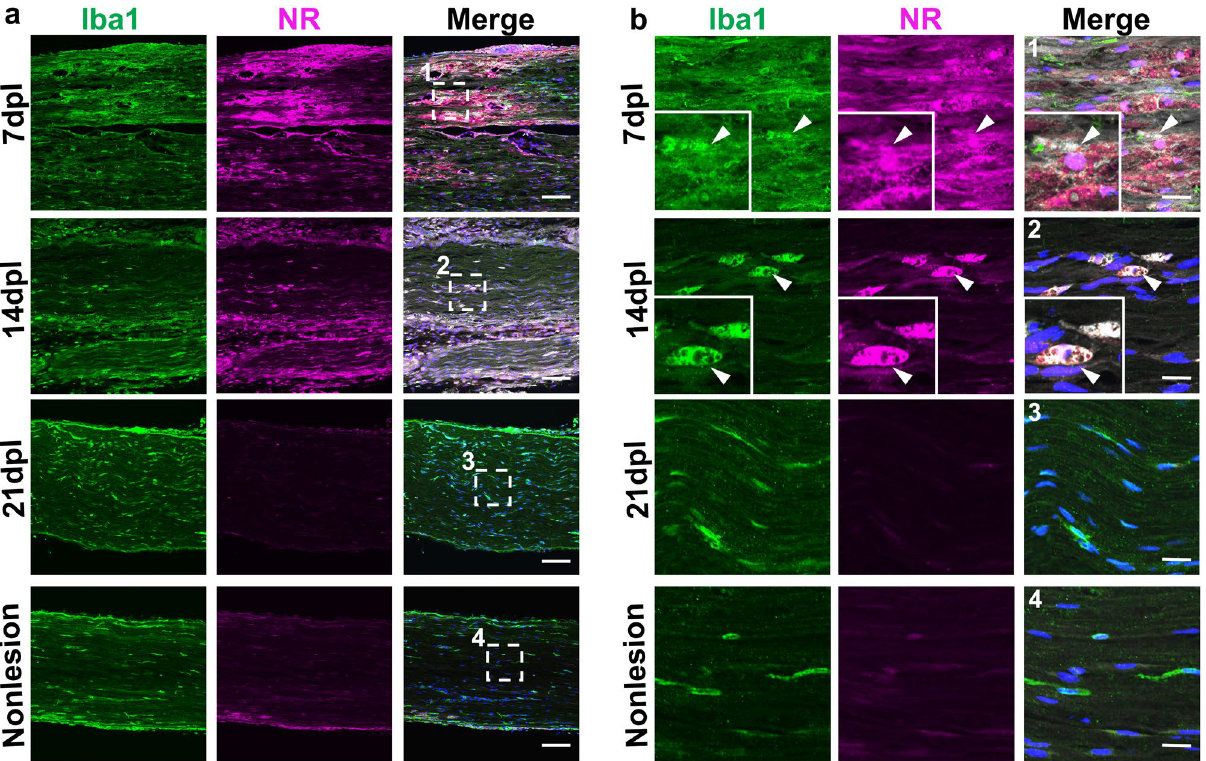
Figure 5. Neutral red (NR) colocalized with Iba1-positive macrophages in demyelinated lesions. ( a ) Representative confocal images of NR (magenta) and immunofluorescence staining for macrophages labeled with anti-Iba1 (green) at low ( a ) and high ( b ) magnification in areas with lysophosphatidylcholine injection at 7, 14 and 21 dpl and a nonlesion area at 7 dpl (n = 3 mice per timepoint examined). ( b1–4 ) Enlarged images of ( a1–4 ) (white dotted square). Iba1-positive macrophages colocalized with NR (arrowhead). Insets Enlargements of double-positive cells. No NR labeling was detected in Iba1-positive macrophages in nonlesion area. Scale bar, 50 µm ( a ) and 20 µm ( b ). Nuclei were counterstained with Hoechst